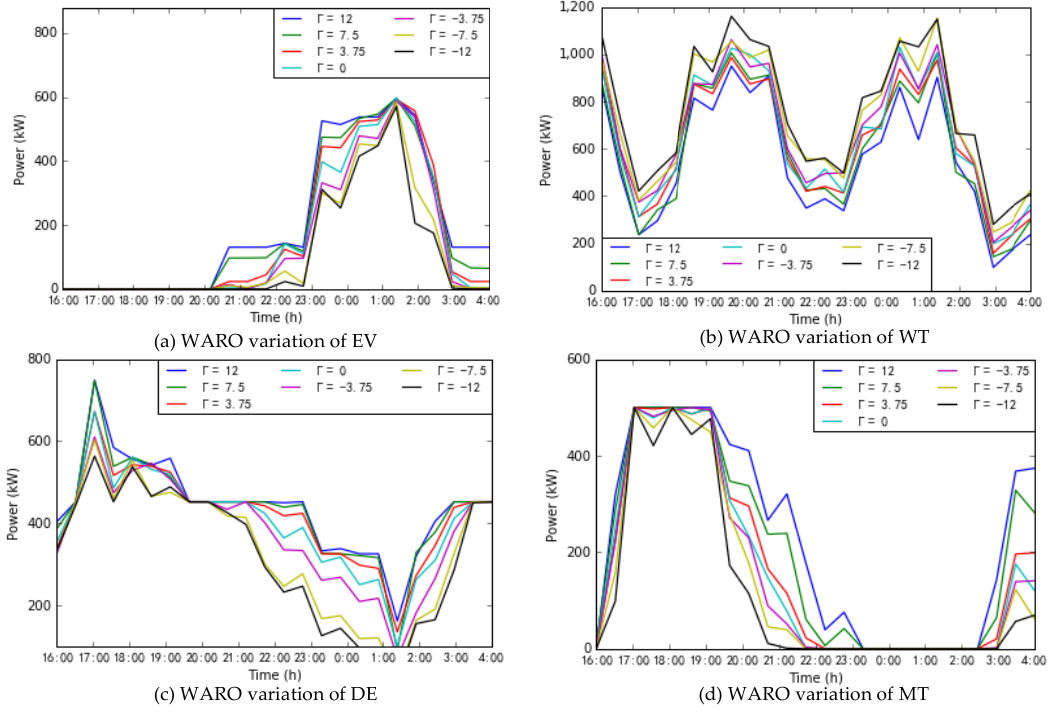
Figure 10 . Comparison of DG performances for different ARO parameters. Figure 10. Comparison of DG performances for different ARO